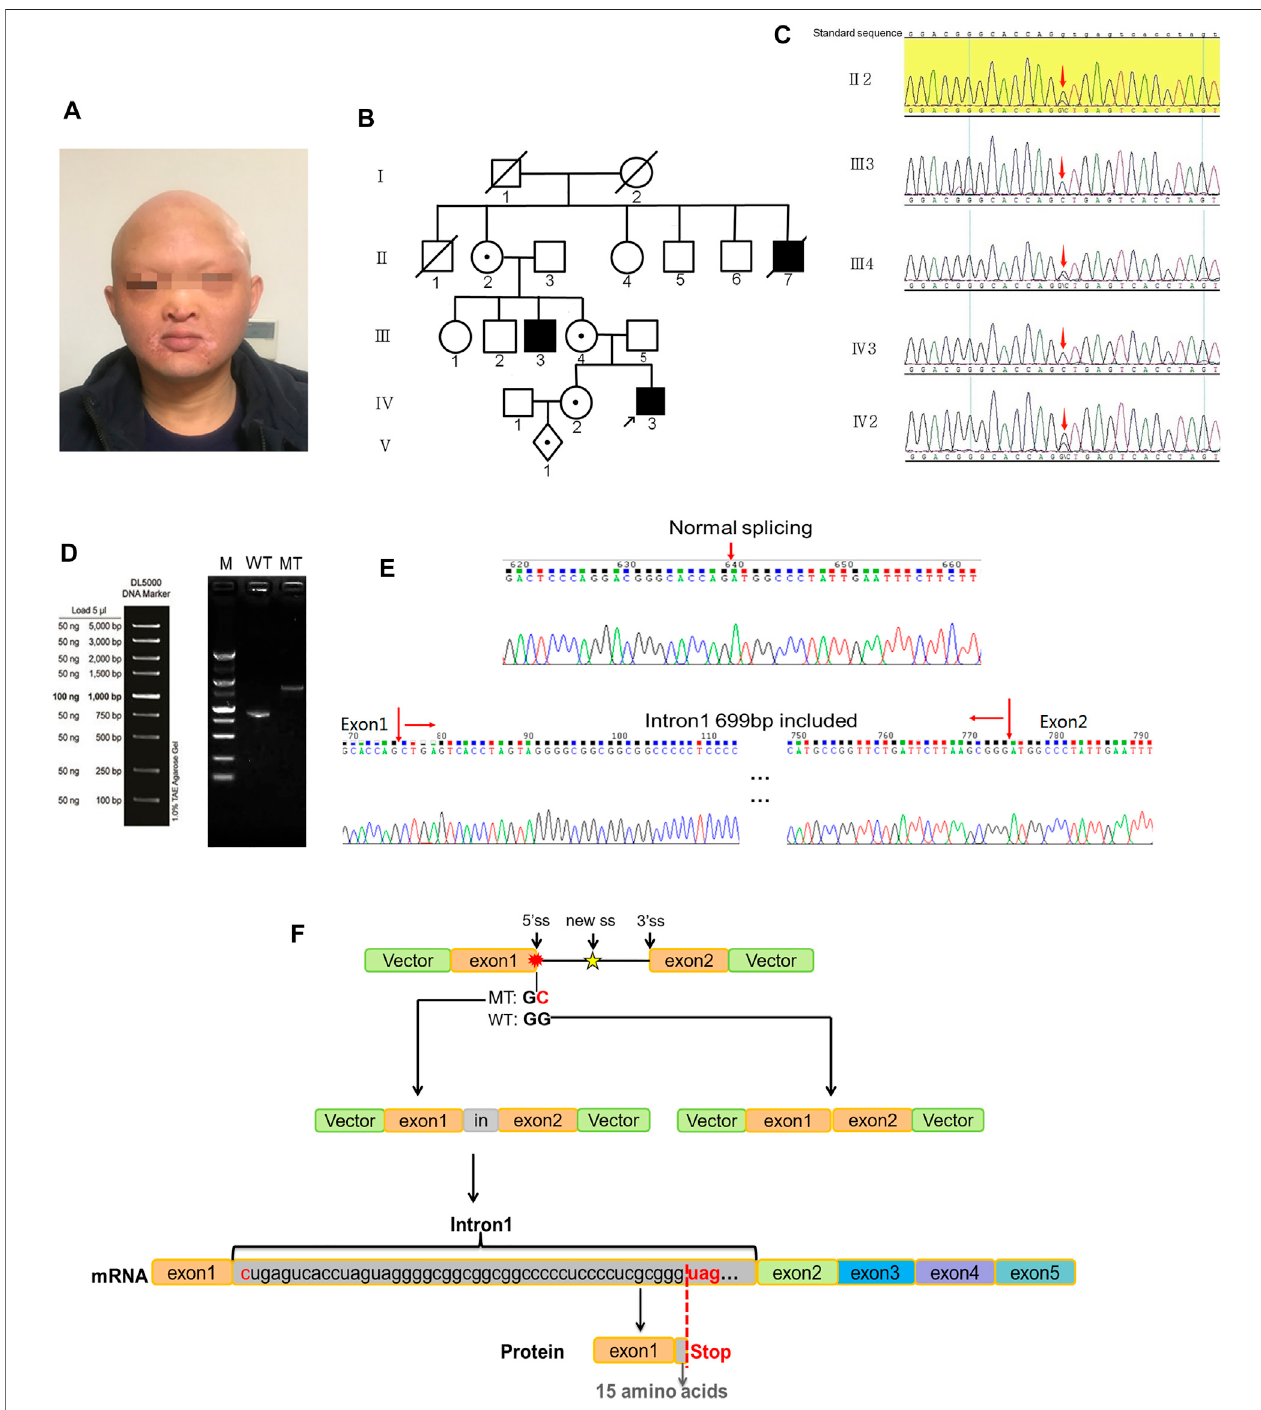
FIGURE1| Variantsincase 1. (A) Frontal photograph ofproband1showingvarious developmentaldefectsofectodermal appendagesincluding protuberantlips, short chin, and fl at nose. (B) Familytreeshowingthatthe proband ’ suncle(III3) and uncle ’ sgrandpa (II7)wereHEDpositive. (C) Validationofthemutation sitebySanger sequencing. The red arrow indicates the mutated base. (D) Electrophoretogram results of transcripts generated from the transfected WT and MT EDA minigenes. Lane M,5,000 bpmarkers;LaneWT,WTEDAminigenetranscriptsshowingasinglebandof821 bp;LaneMT,MTminigenescontainingmutantallelesshowingalonger band(theemptylanehasbeencropped). (E) Inclusionofanextra699nucleotidesinintron1validatedbySangersequencing. (F) Thesplicingandtranscriptionpatternof MT EDA pre-mRNA.